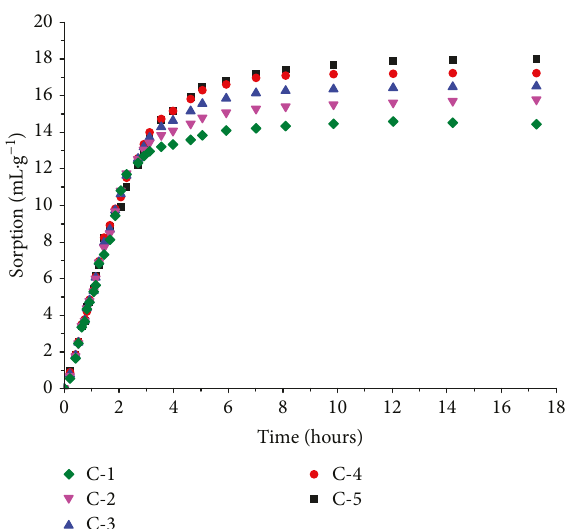
Figure 7: Kinetics of gas sorption for coal samples.